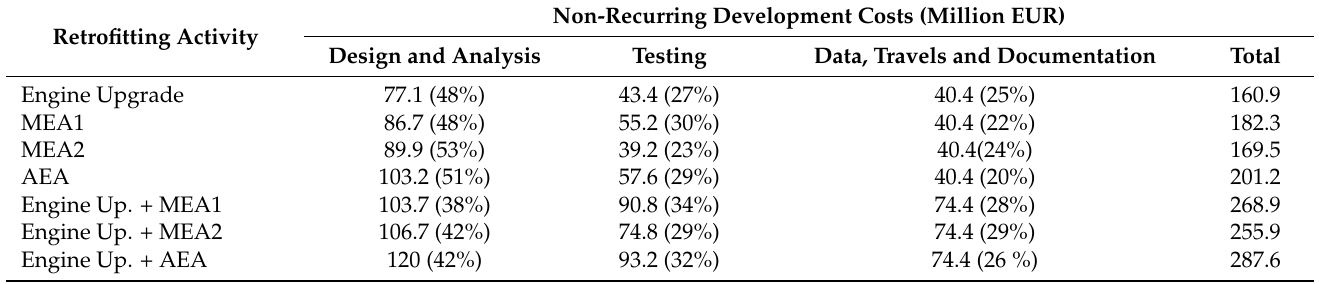
Table 6. List of the main development costs, computed for seven different retrofits.